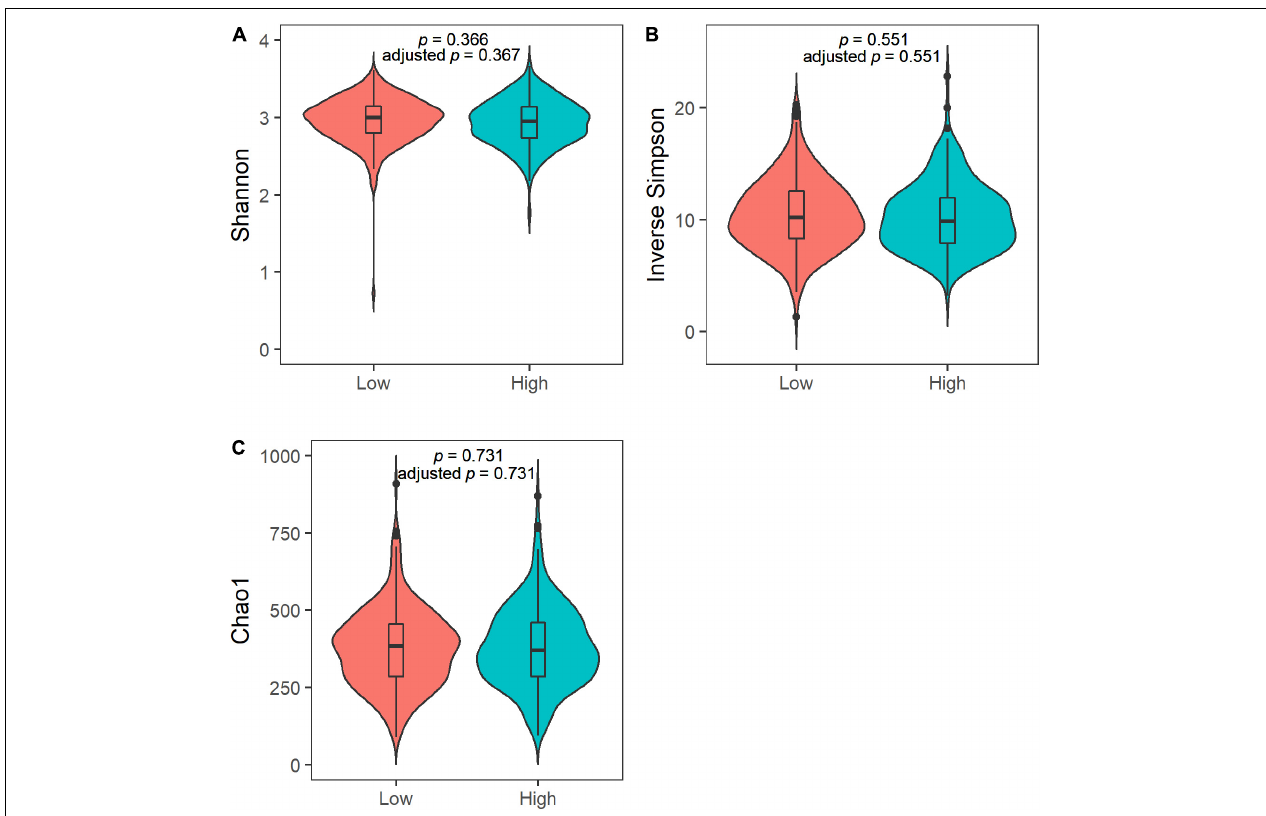
FIGURE 1 | Violin plots of the alpha diversity in the saliva microbiota in children with low ( n = 227) and high ( n = 226) sweet treat consumption for (A) Shannon index, (B) Inverse Simpson index, and (C) Chao1 index. Adjusted p -value based on an analysis adjusted for sex, age, waist–height ratio, and maternal socioeconomic status. Results from ANOVA and